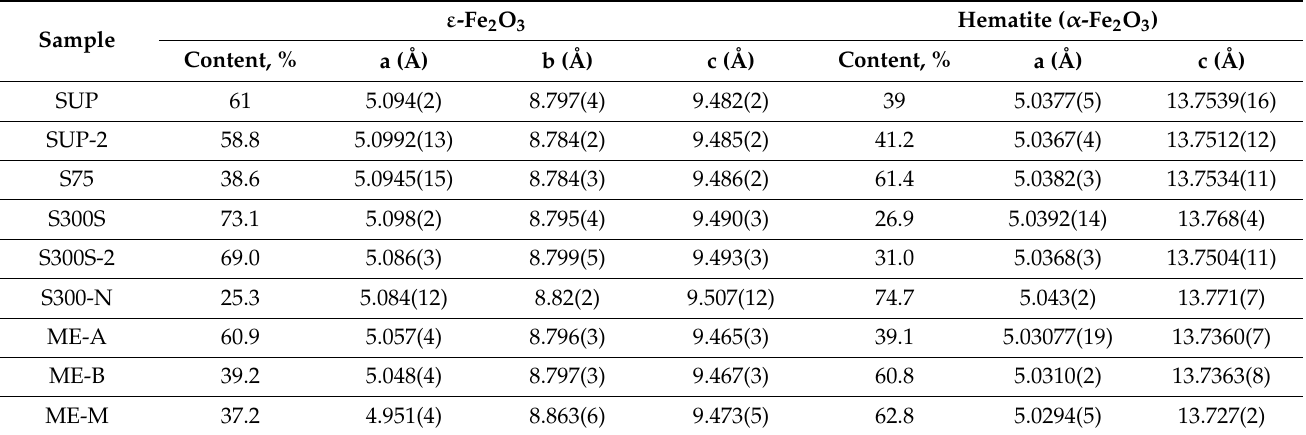
Table 3. Results of X-ray